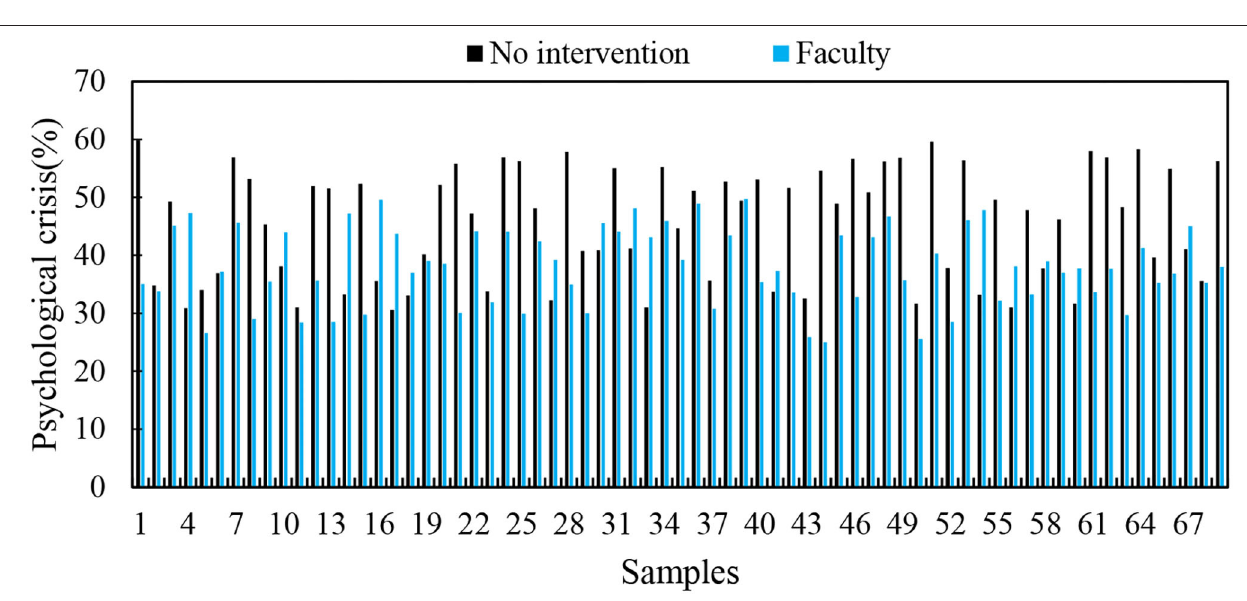
FIGURE 4 | The impact of the improvement of the teaching quality of the teaching staff on the psychological crisis of